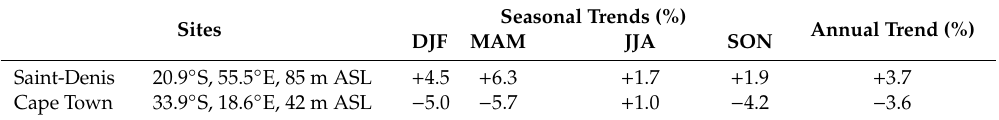
Table 2. Annual and seasonal UV trend estimates (in percentages) computed from daily total doses (SED) as derived from UVI observations at Saint-Denis in Reunion Island and Cape Town in South